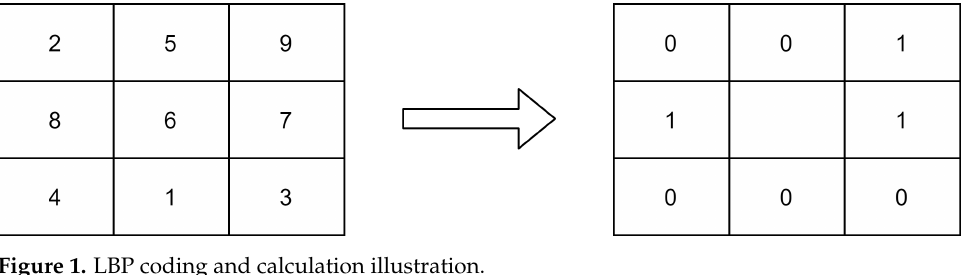
Figure 1. LBP coding and calculation